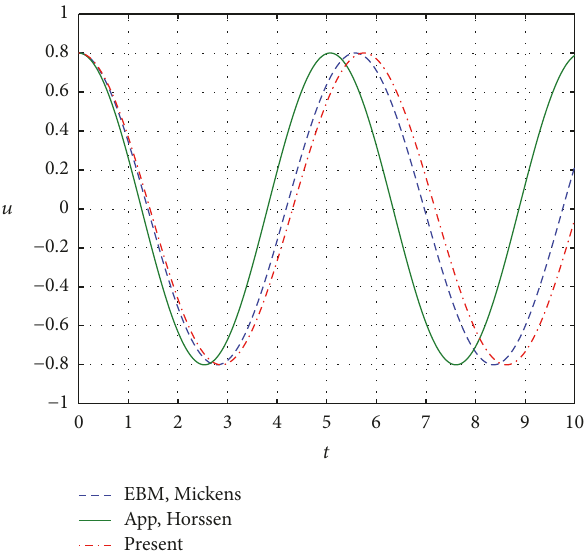
Figure 14: Comparison of time history diagram of displacement between the Present, HBM [23] and App [34] solutions with 𝑛 = 50 , Example